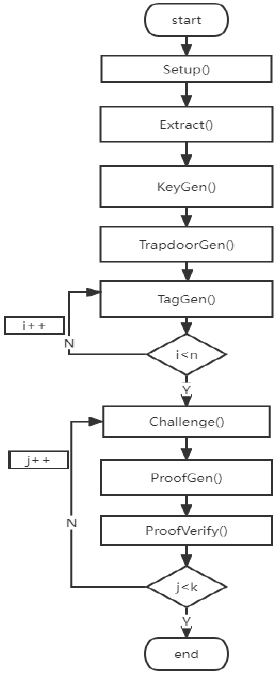
Figure 2. Algorithm